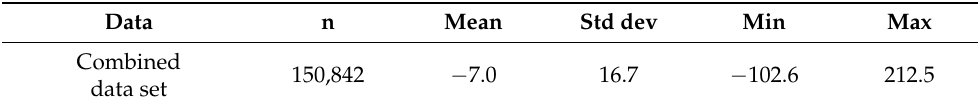
Table 1. Statistics of the gravity data used in this study (in mGal).